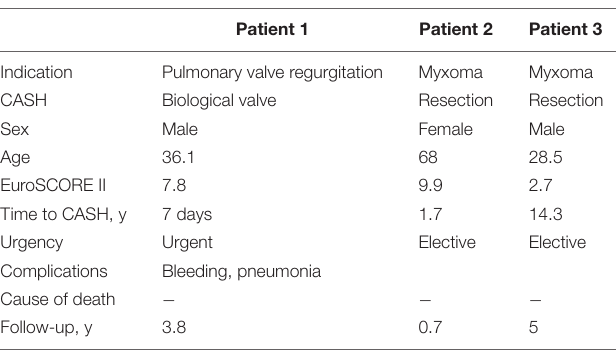
CASH, cardiac surgery after heart